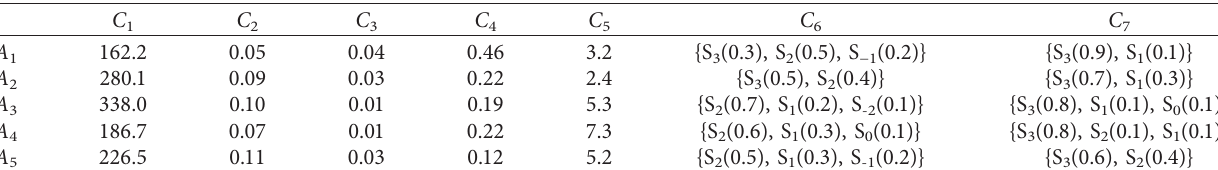
Table 1: Data information.